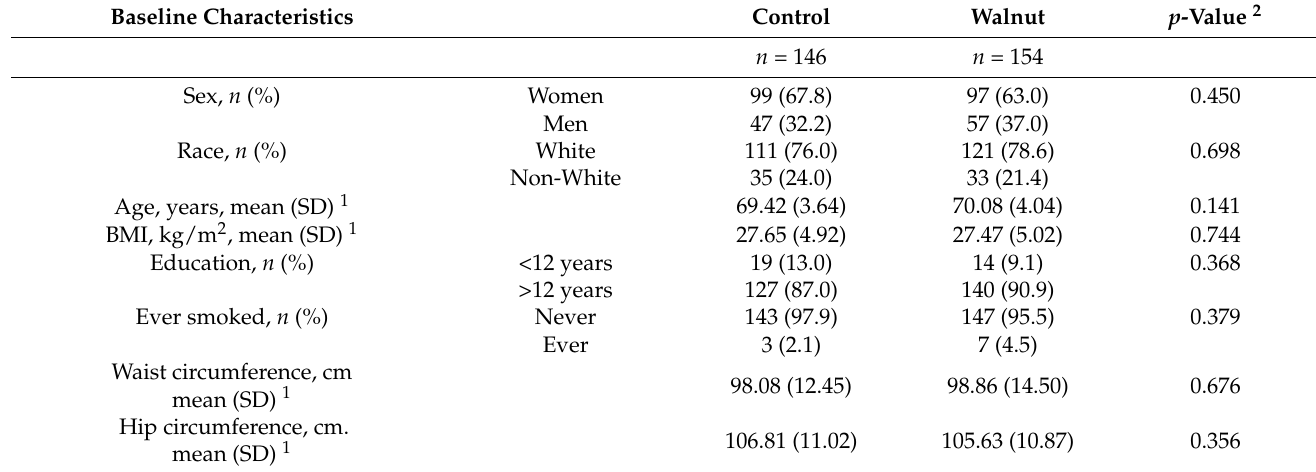
Table 1. The subject characteristics of the study by treatment group ( n = 300).